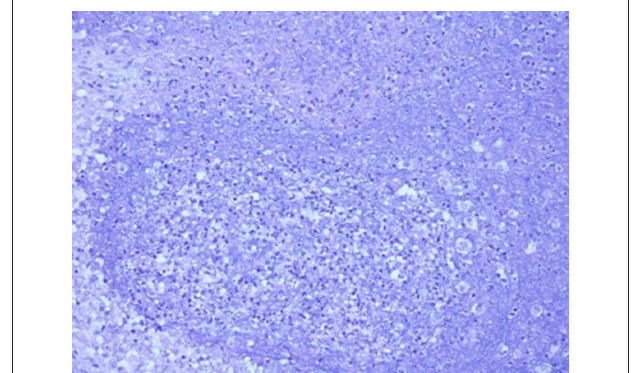
Figure 3 | Hematoxylin and eosin staining.